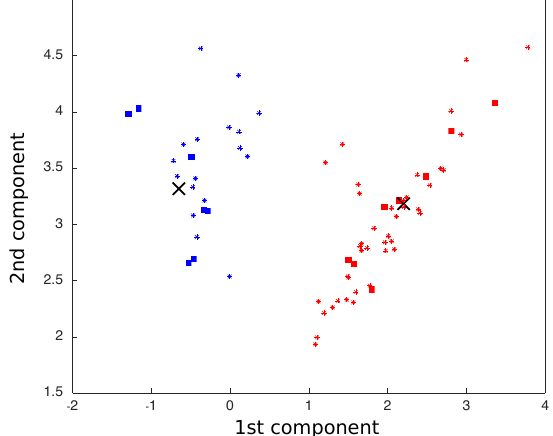
Figure 4. Representative example of movement classification with the IMU. Squares represent the movements used for calibration whereas stars are the movements classified online. The big “X” are the classes